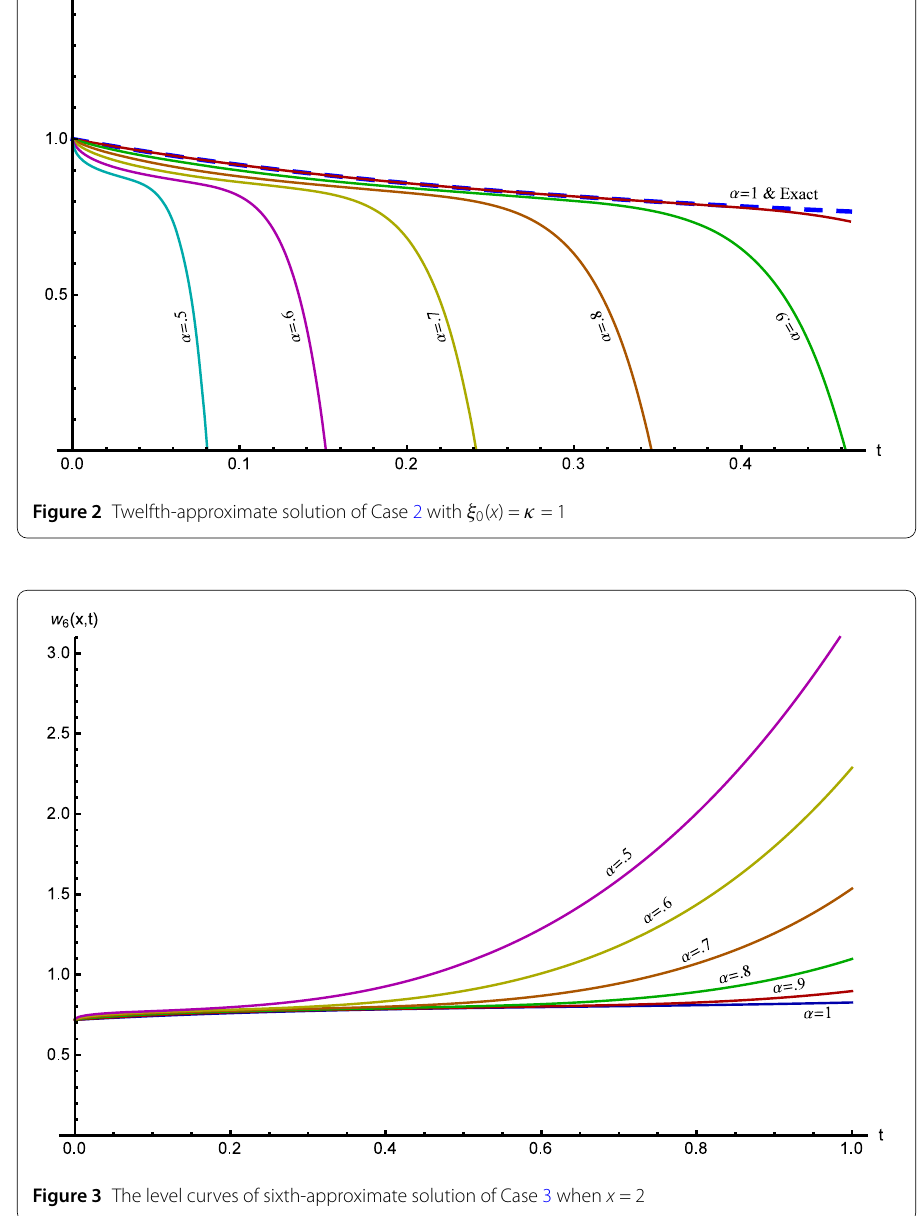
Figure 3 The level curves of sixth-approximate solution of Case 3 when x =